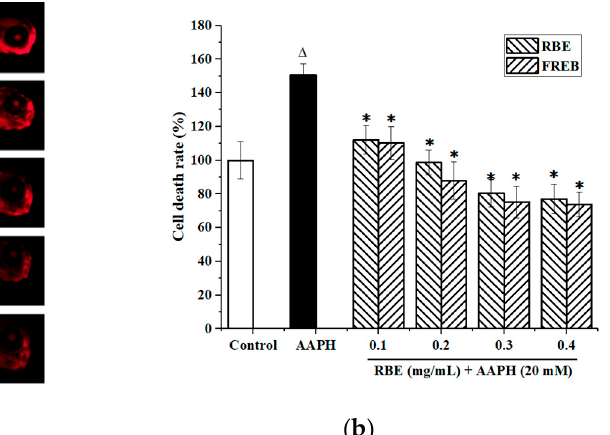
Figure 4. Protective effect of RBE and FRBE on AAPH-treated cell death in zebrafish. ( a ) Cell death levels were measured by image analysis and fluorescence microscopy. ( b ) Cell death levels were measured using Image J software. Experiments were performed in triplicate, and data are expressed as the means ± SE; Δ p < 0.05 compared to the control group; * p < 0.05 compared to the AAPH- treated group.